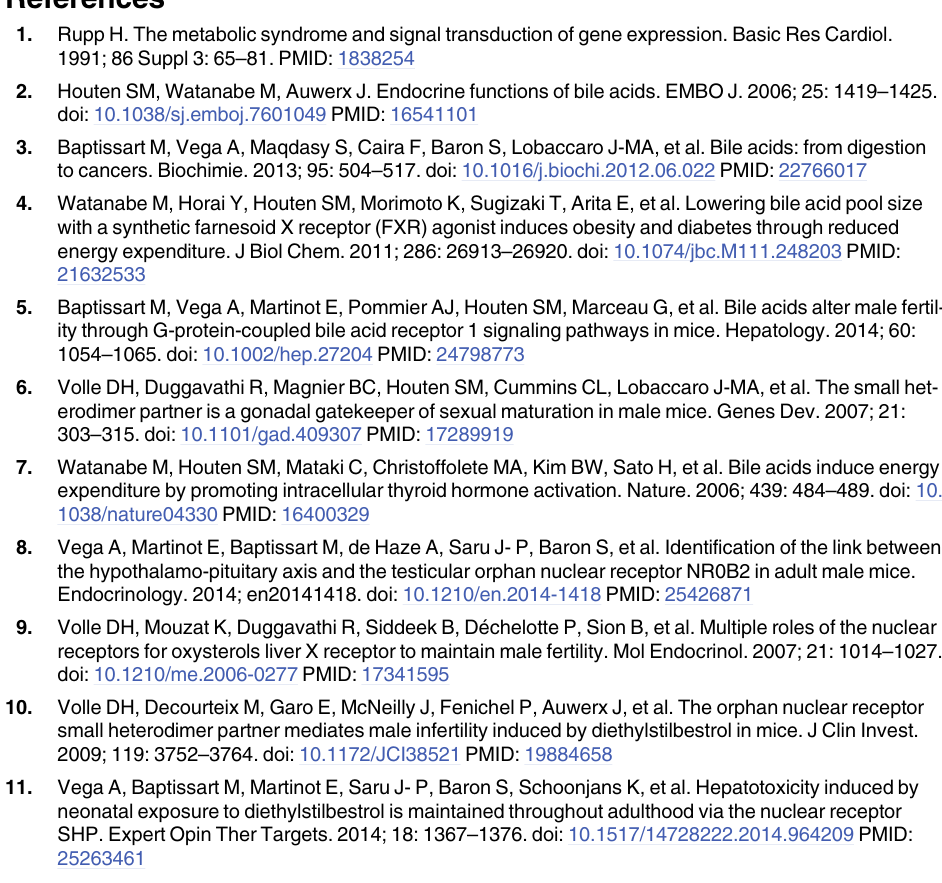
S3 Fig. (A) Apoptosis in mice fed chow or HFD (n = 13 to 25 per group) analyzed by TUNEL staining. The arrow indicates apoptotic spermatocytes. The original magnification was X200. The number of TUNEL-positive cells per 100 seminiferous tubes. (B) Intra-tes- ticular cholesterol, cholesterol ester, triglycerides levels in mice fed to HFD or HF-CA diet 2 months after the switch to HF-CA diet. (n = 19 – 25 per group). (C) Intra-testicular choles- terol, cholesterol ester, triglycerides and glucose levels in mice fed to HFD or HF-CA diet 4 months after the switch to HF-CA diet. (n = 19 – 25 per group). S1 Table. The list of the antibodies used in the present work. (XLSX) S2 Table. The list of the primer sequences used in the present work.